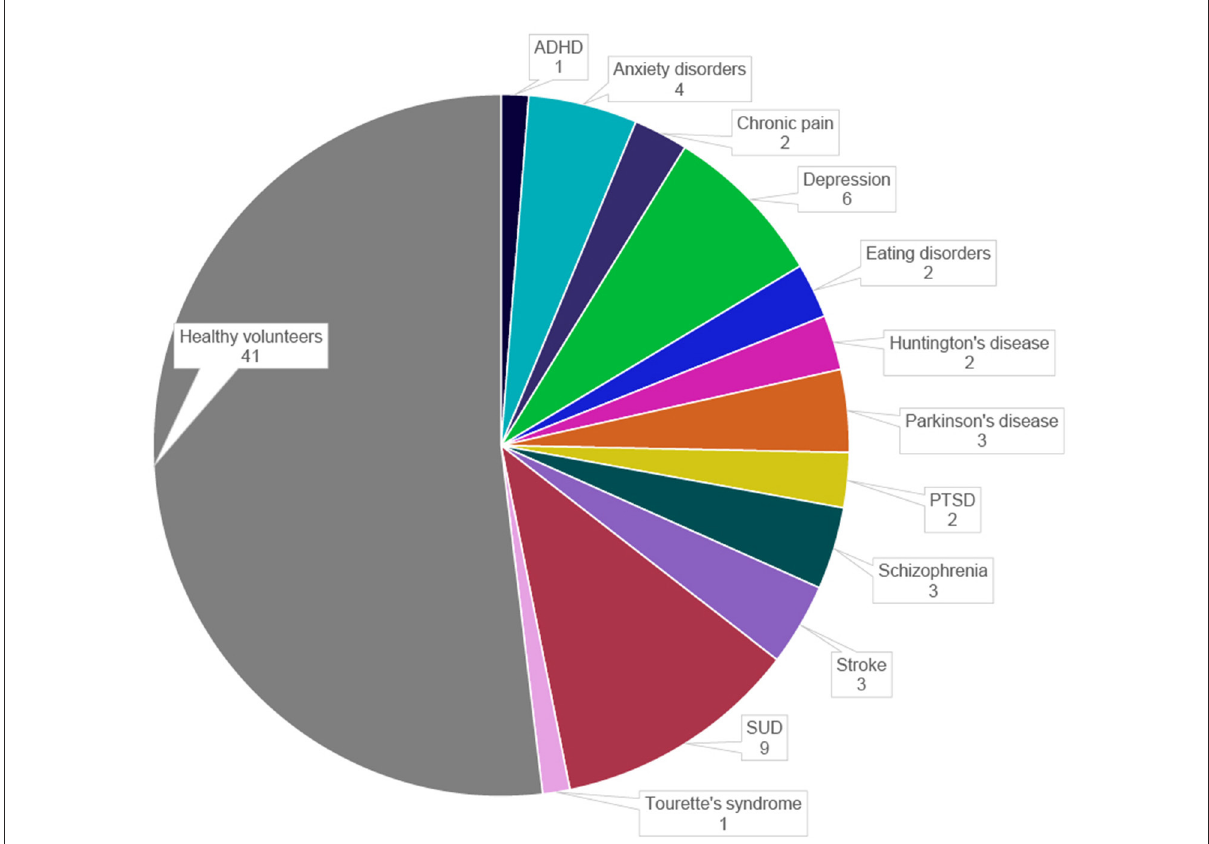
FIGURE3 Distribution of study populations in the selected publications. ADHD, attention deficit hyperactivity disorder; PTSD, post-traumatic stress disorder; SUD, substance-use